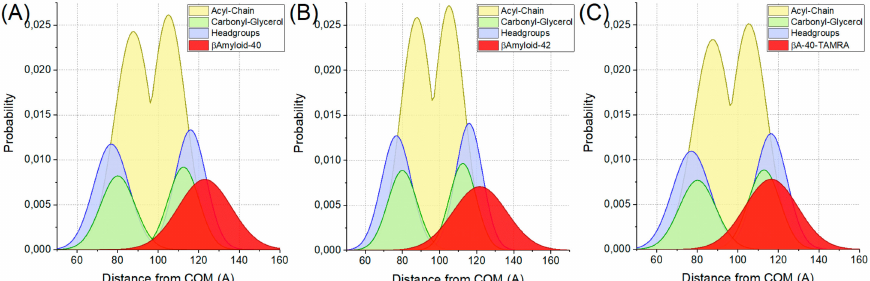
Figure 2. Probabilities of specified membrane regions for POPC vesicles with ( A ) A β -40, ( B ) A β -42 and ( C ) A β -40-TAMRA peptides incorporated in function of distance from center of mass. Specified regions are headgroups (blue), carbonyl-glycerol (green), acyl-chain (yellow) and peptides